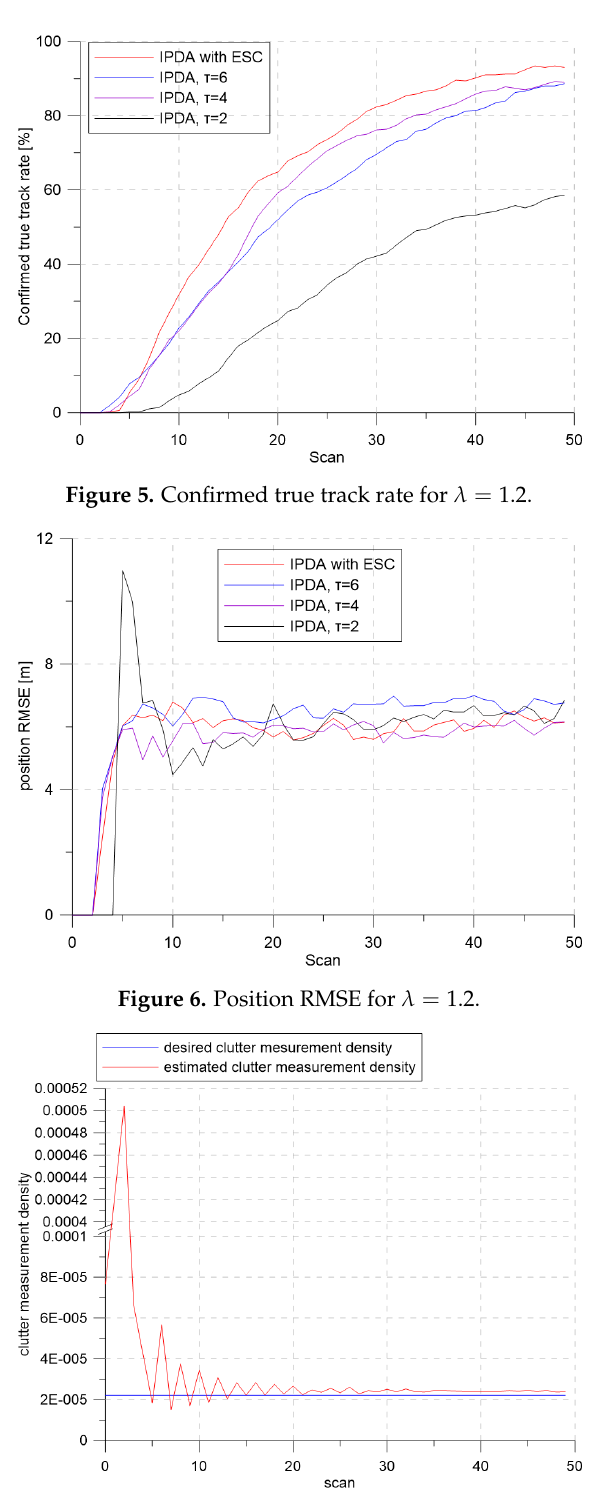
Figure 7. The desired clutter measurement density and estimated clutter measurement density for λ =